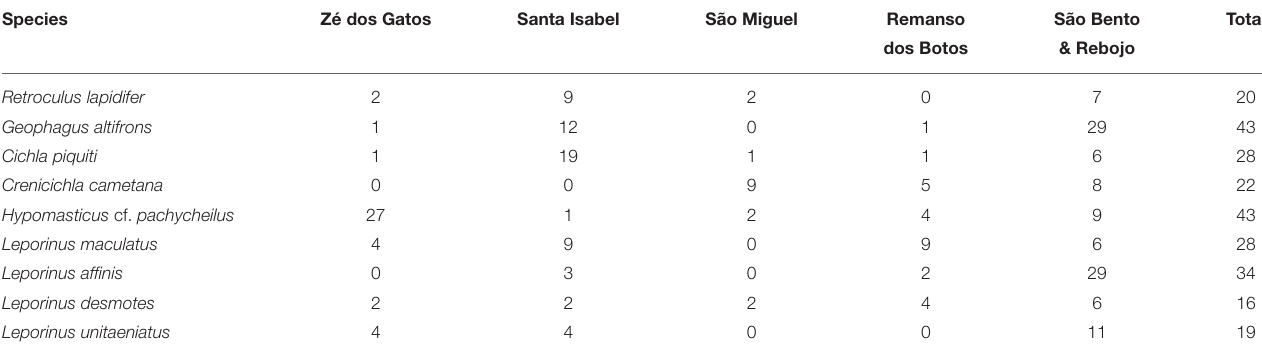
TABLE 2 | Number of individuals of each species analyzed from the rapids of the Araguaia River. Species Zé dos